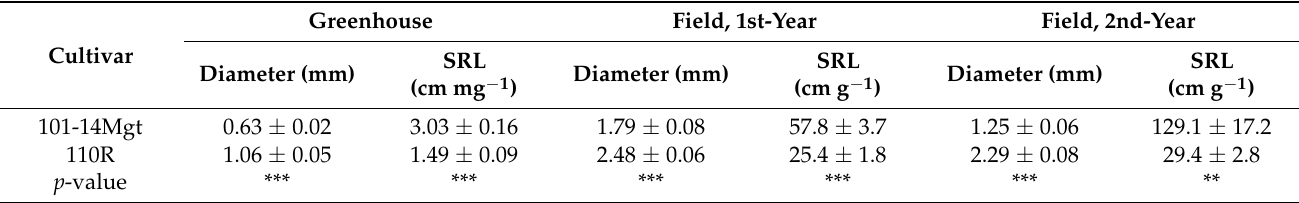
For the greenhouse, differences between rootstocks were determined using Welch’s t -test. Differences in field grown vines were determined with t -test. p < 0.01 = **; p < 0.001 =